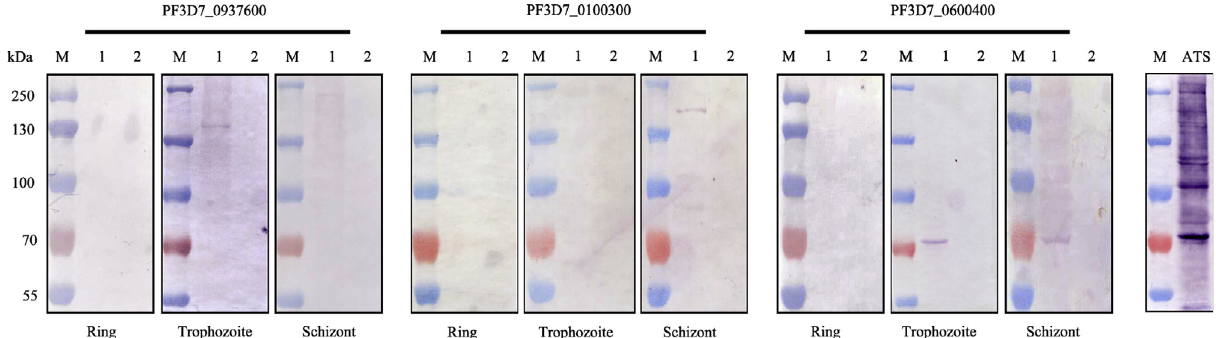
Figure 3. Western blot analysis of native proteins in three developmental stages. The expression of the native proteins encoded by the three var 3 genes (PF3D7_0100300, PF3D7_0600400, and PF3D7_0937600) in the ring, trophozoite, and schizont stages were, respectively, detected by the variant-specific antibodies generated in rats. Lanes 1 and 2 represent results from infected red blood cells and uninfected red blood cells, respectively. A band of approximately 152 kDa was detected in the late trophozoite stage (24–30 h p.i.) with the antibody specific to PF3D7_0937600. A band of approximately 153 kDa was detected in the schizont stage (36–44 h p.i.) with the antibody specific to PF3D7_0100300. And a band of approximately 70 kDa was detected in both the trophozoite stage and schizont stage (24–44 h p.i.) for the PF3D7_0600400-specific